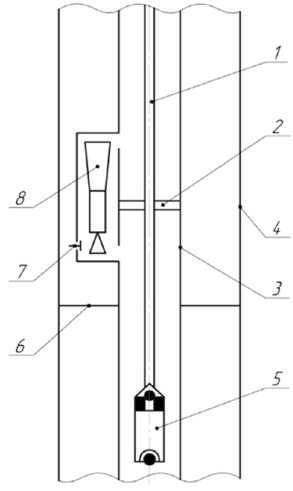
Figure 1. General layout of the tandem installation [84]: 1—rods; 2—separator; 3—tubing string; 4—casing; 5—sucker-rod pump; 6—dynamic level; 7—check valve; 8—oil-gas jet pump.